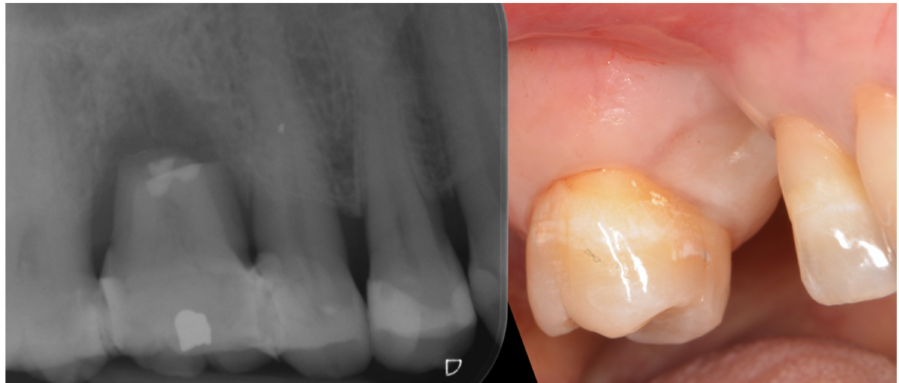
Figure 5. Broken tooth was splinted in place to favor healing of the soft